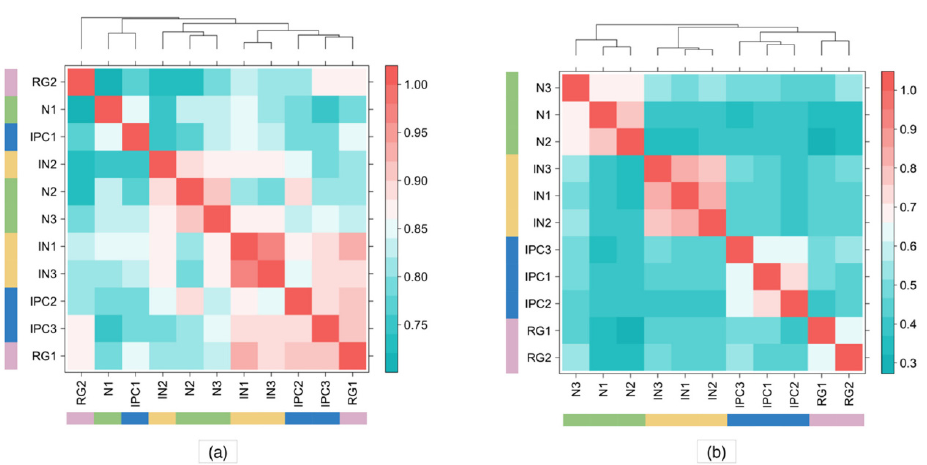
Figure 5. Comparison of HPRep and HiCRep in human brain PLAC-Seq datasets. ( a ) HiCRep and ( b ) HPRep. Dendrograms above the heatmaps indicate clustering determined by hclust function in R. HiChIP dataset consisted of three neurons, three interneurons, two radial glial, and three intermediate progenitor cell samples. Red color signifies results indicating stronger